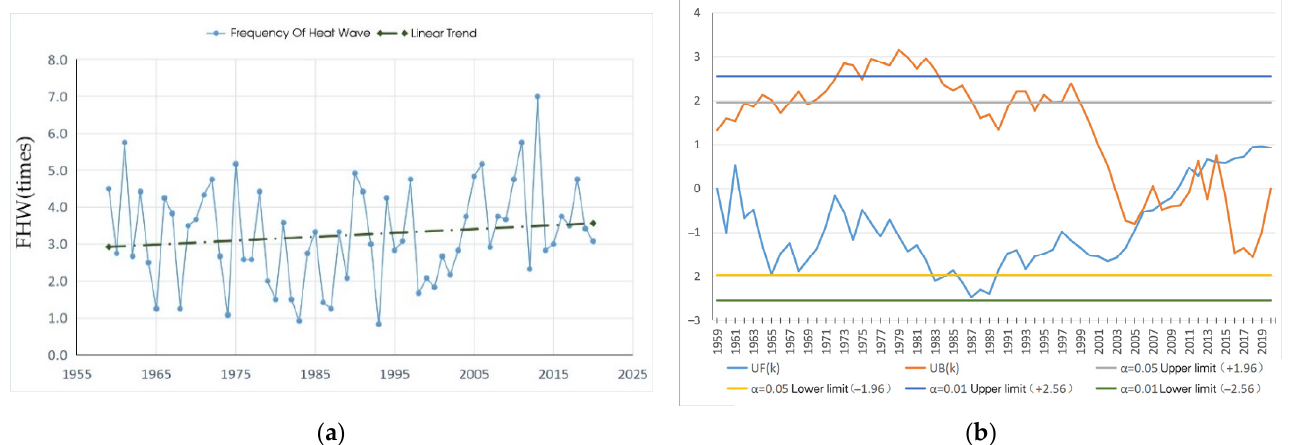
Figure 2. Historical changes in the FHW in Chongqing from 1959 to 2020 and M-K test curves; ( a ) changes in FHW; ( b ) M-K test curves.